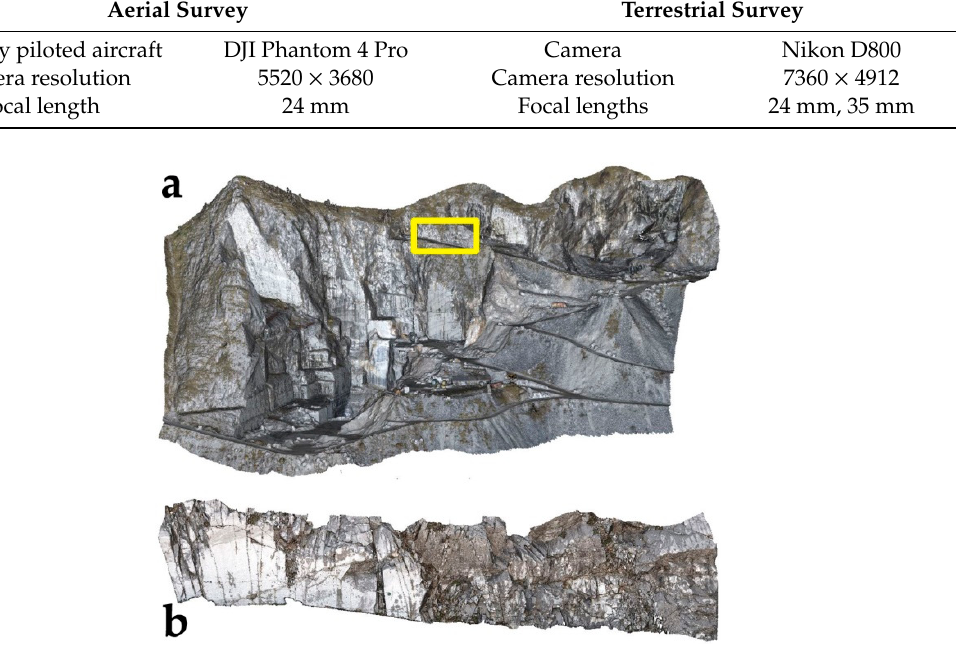
Figure 9. Point cloud representing ( a ) the entire quarry (in yellow the location of bench in the quarry); ( b ) the studied bench